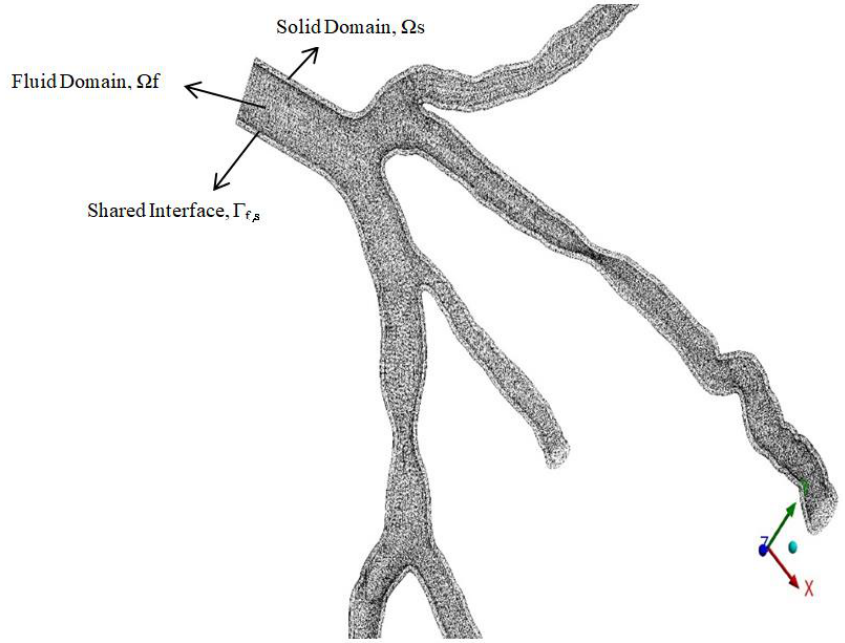
Figure 4. Fluid structure Interaction domains and boundary interfaces.